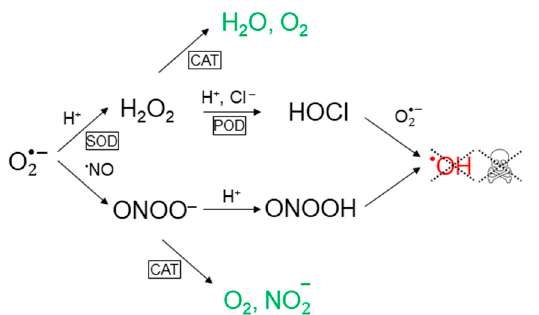
Figure 2. Catalase prevents the formation of hydroxyl radicals in both apoptosis-inducing signaling pathways. In the hypochlorous acid pathway, this occurs through decomposition of hydrogen peroxide into water and oxygen, and in the nitric oxide/peroxynitrite pathway, it proceeds through decomposition of peroxynitrite into nitrite and oxygen.